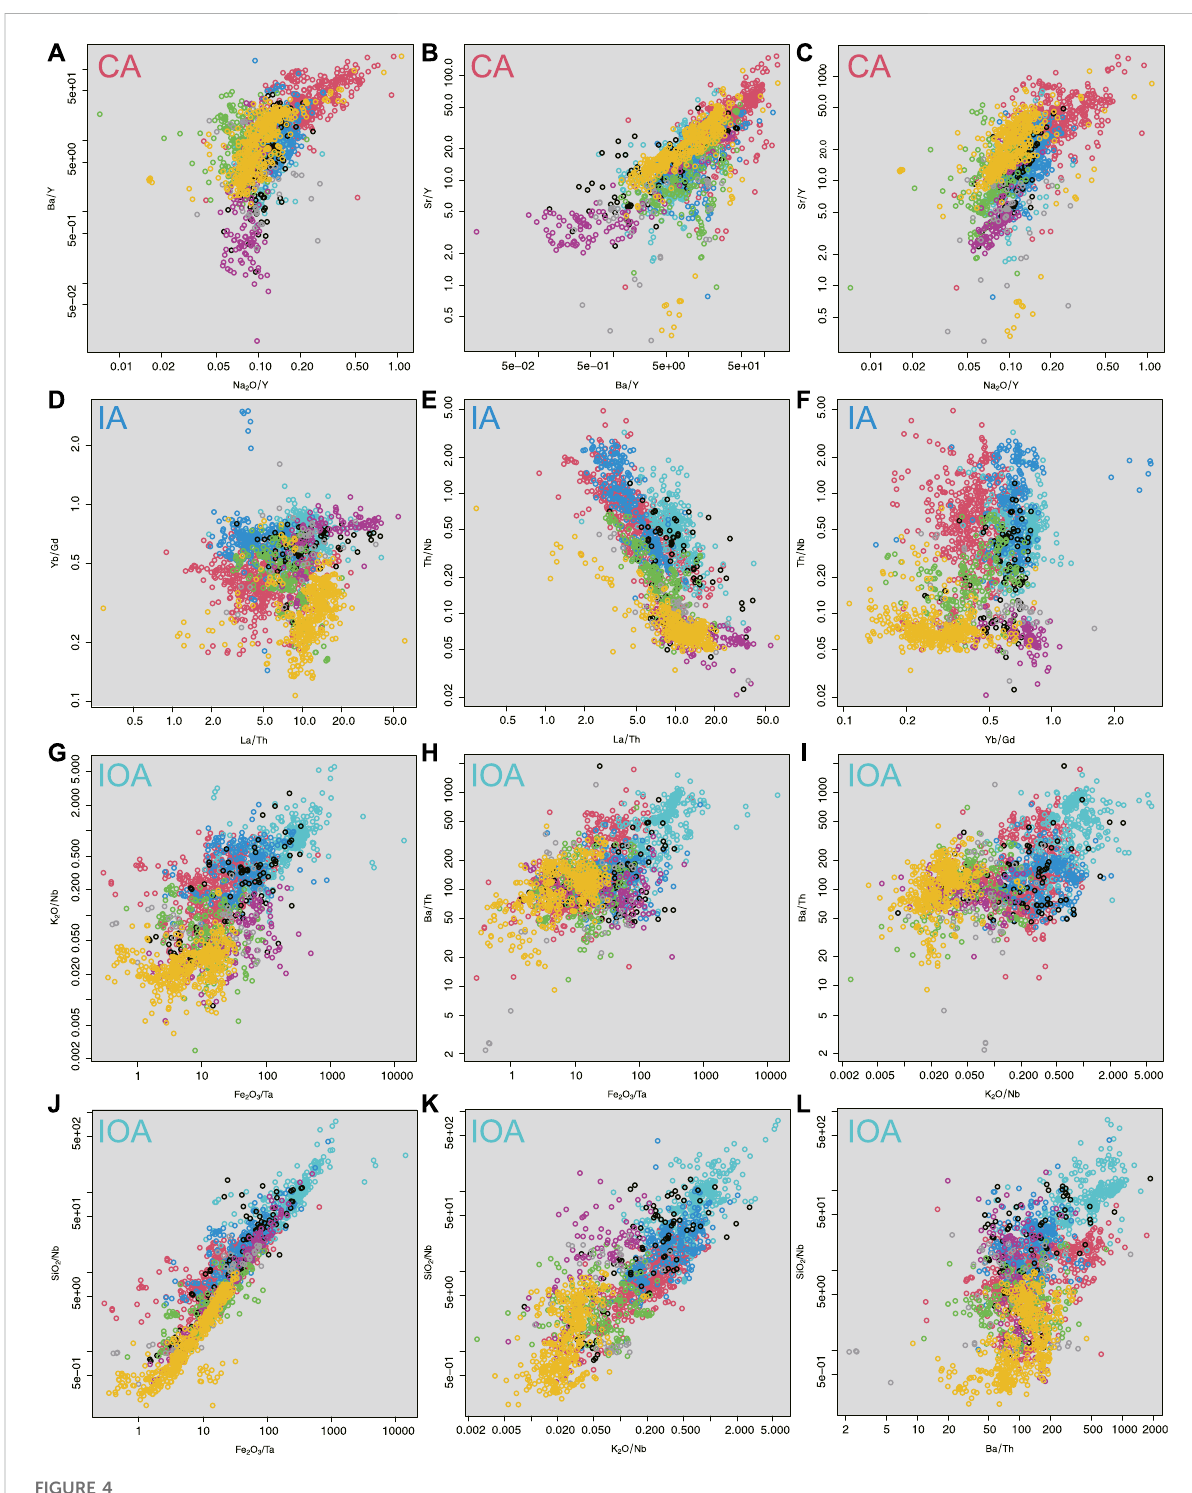
FIGURE 4 Bivariate plot of the key geochemical features (Table 1) of CA, IA, and IOA settings. Symbols are as in Figure 2. (A – C) Geochemical features selected from CA settings (Na 2 O/Y, Ba/Y, and Sr/Y). Samples at upper right exhibit a more CA-like signature. (D – F) Geochemical features selected fromIA settings(La/Th, Yb/Gd,and Th/Nb).OnLa/Th – Yb/Gd and La/Th – Th – Nbdiagrams,samplesatupper leftexhibitamore IA-likesignature.On a Yb/Gd – Th/Nb diagram, samples at upper right exhibit a more IA-like signature. (G – L) Geochemical features selected from IOA settings (Fe 2 O 3 /Ta, K 2 O/Nb, Ba/Th, and SiO 2 /Nb). Samples at upper right exhibit a more IOA-like